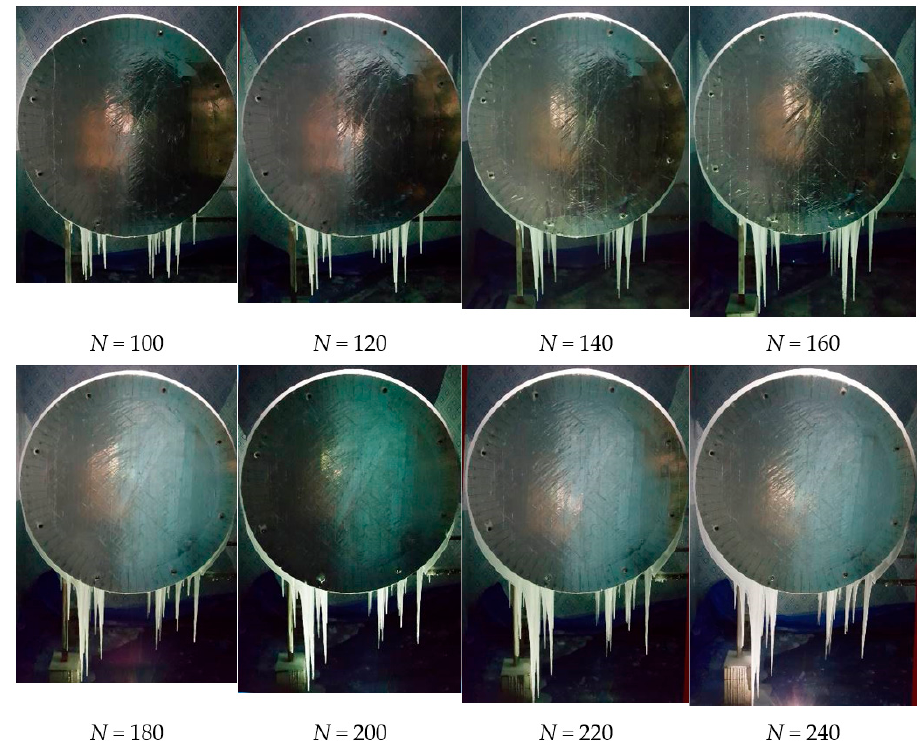
= 1000 mm). Figure 11. Profiles of ice accretions for various N ( D = 1000 mm).